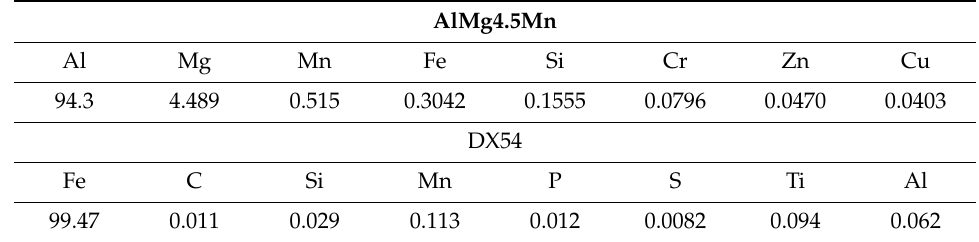
Table 2. Chemical compositions of used materials